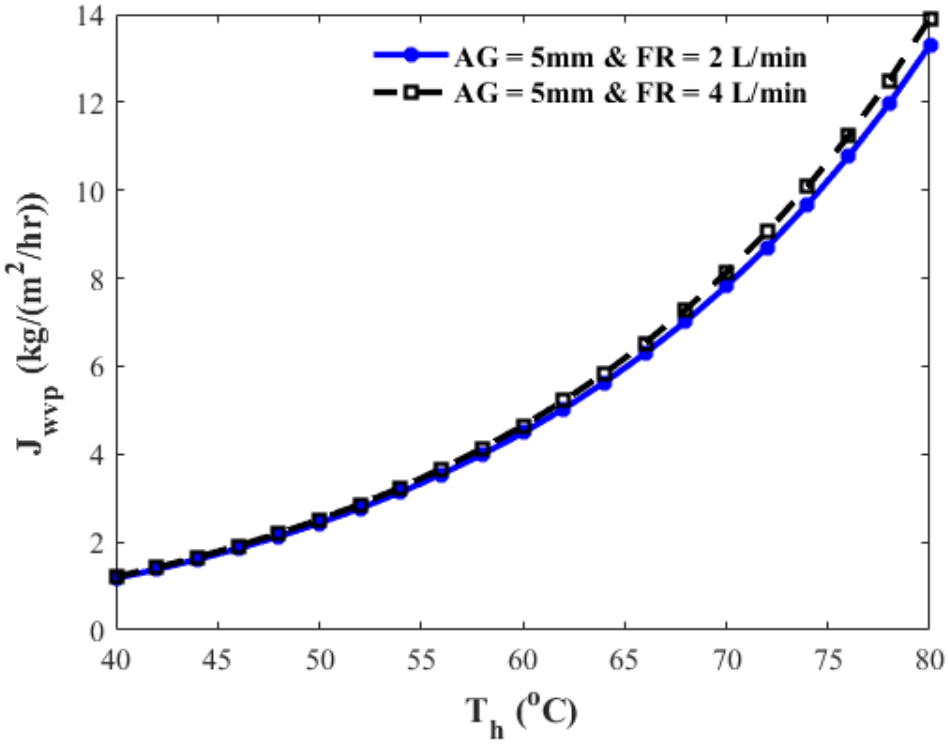
Figure 10. Effect of the hot feed (FR = 2 and 4 L/min) on the permeate (J wvp ) at different hot feed temperatures (T h ) (air gap thickness (AG) of 5 mm).